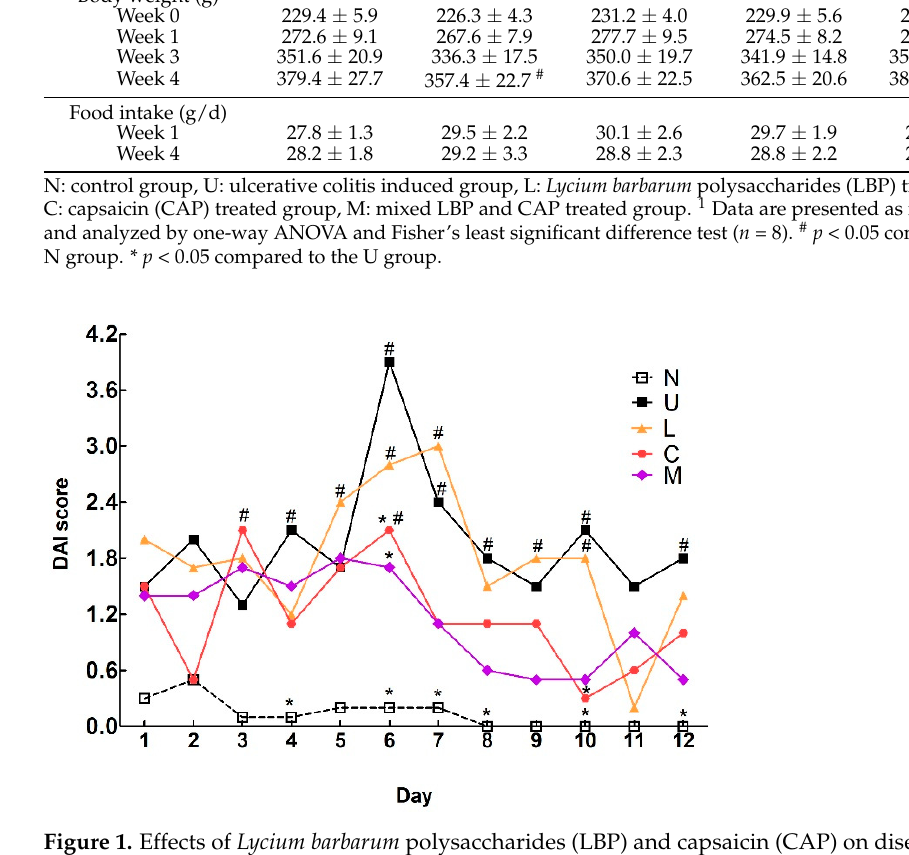
Table 1. Body weight and food intake in rats with or without dextran sulfate sodium-induced colitis 1 . N U